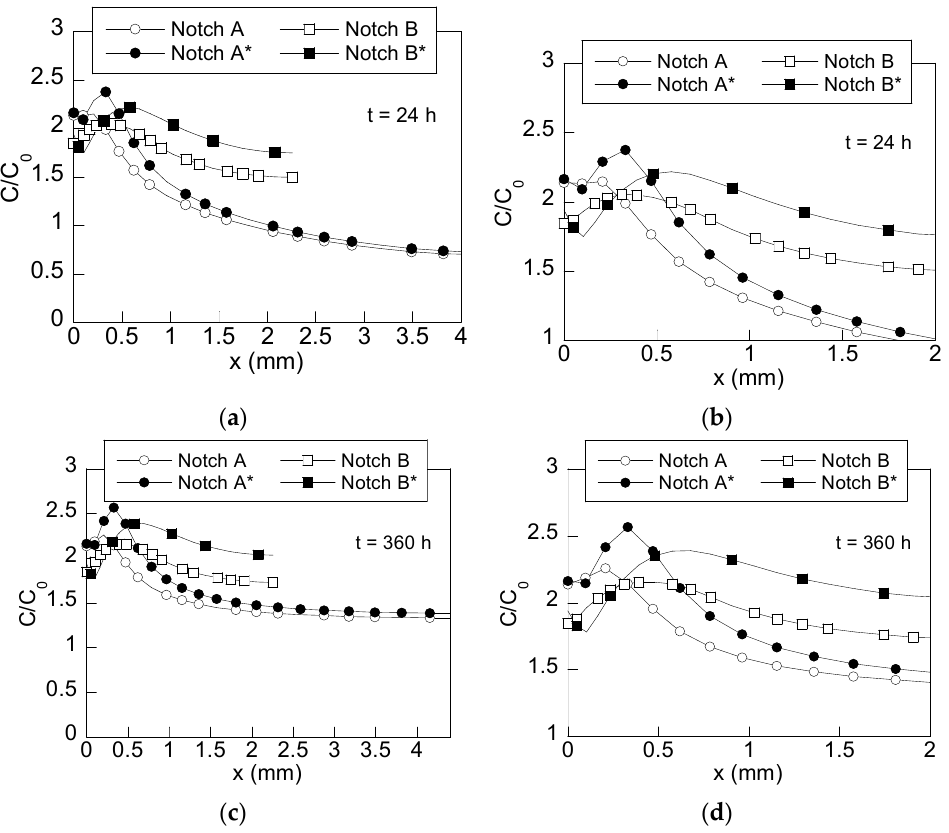
Figure 6. Radial distributions of hydrogen concentration in preloaded (filled) and un-preloaded (blank) specimens under in-service loading (70% P R ): (i) after 24 h of exposure to the hydrogenating environment: ( a ) general view and ( b ) detailed view; (ii) after 360 h of exposure to the hydrogenating environment: ( c ) general view and ( d ) detailed view.